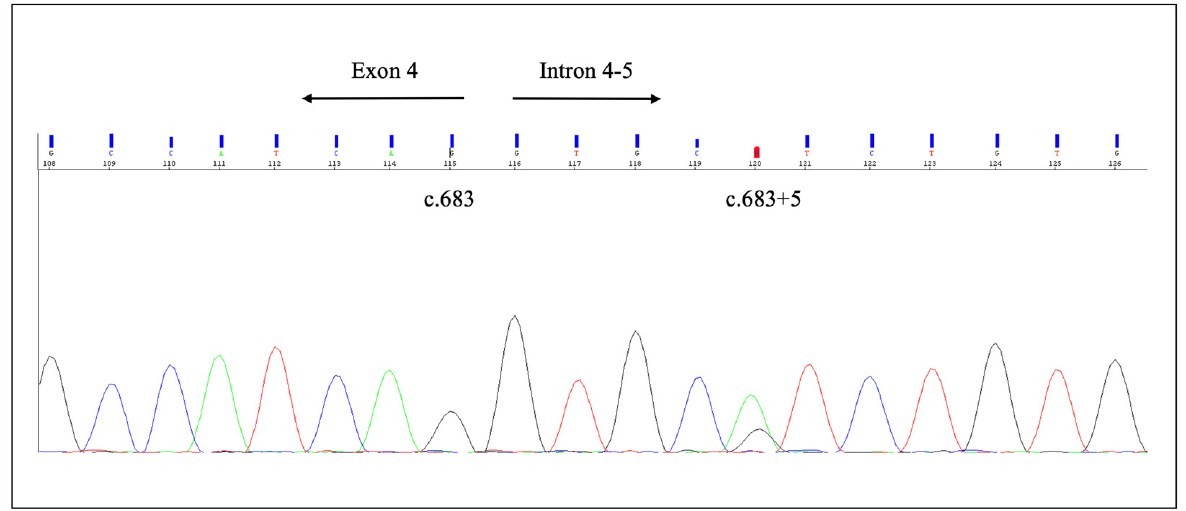
Figure 4. Intronic variant c.683 + 5G > A (rs397508122) in KCNQ1 gene (NM_000218) identified during molecular autopsy.